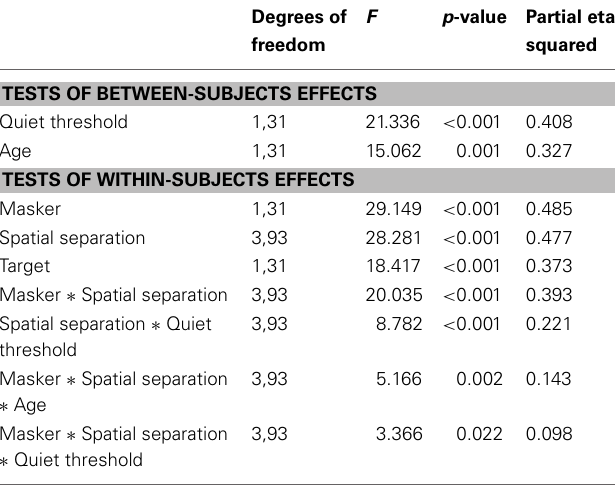
Table 1 | Within-subjects ANOVA for Experiment One.